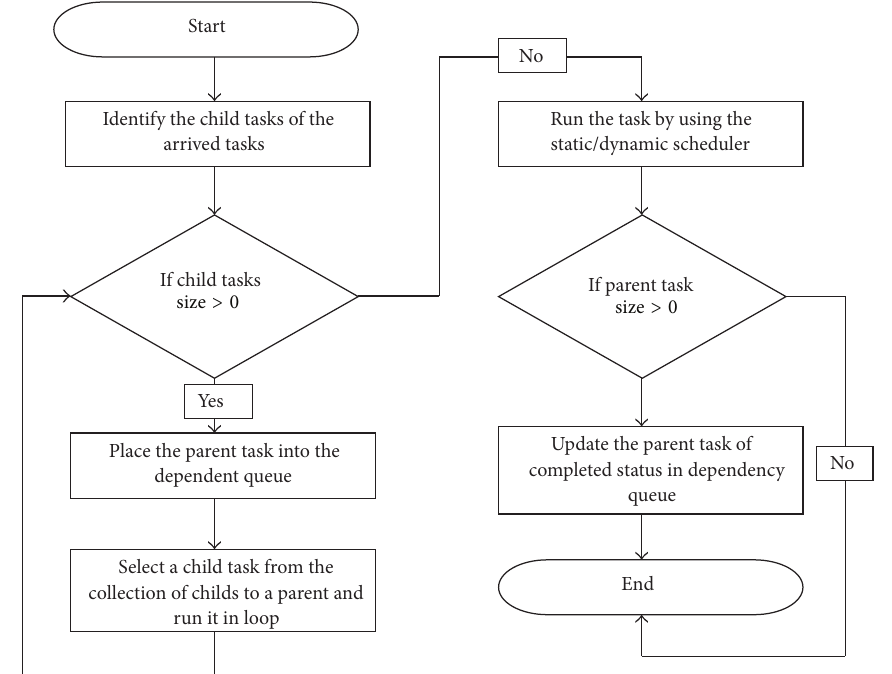
Figure 3: Flow chart of multilevel interdependency